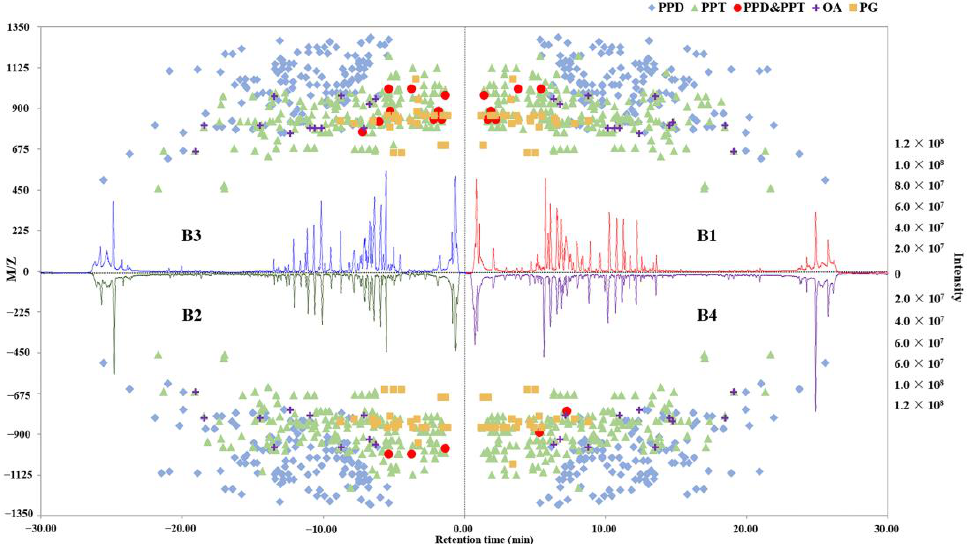
Figure 4. Base peak chromatogram profiles and distribution of various types of ginsenosides in P. ginseng samples.